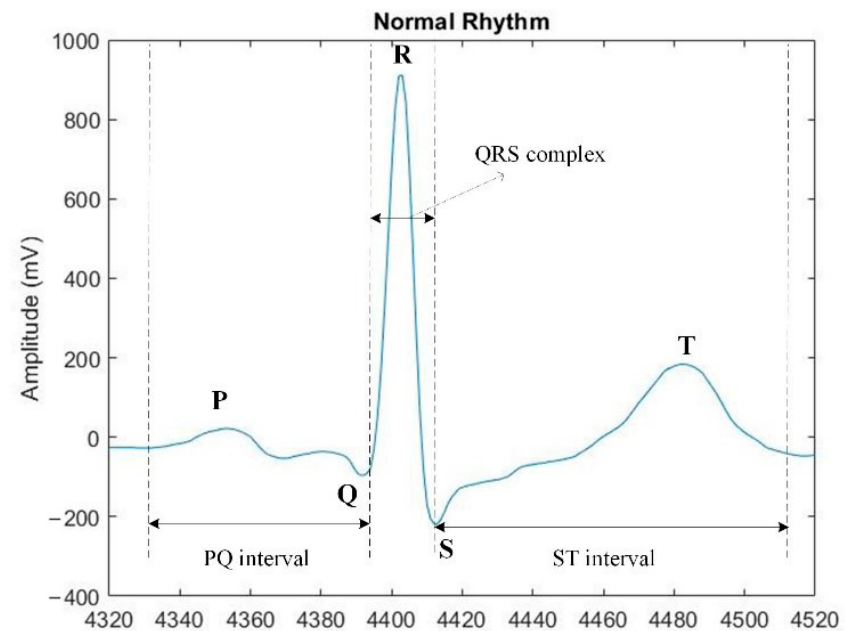
Figure 1. Example of an electrocardiogram signal.